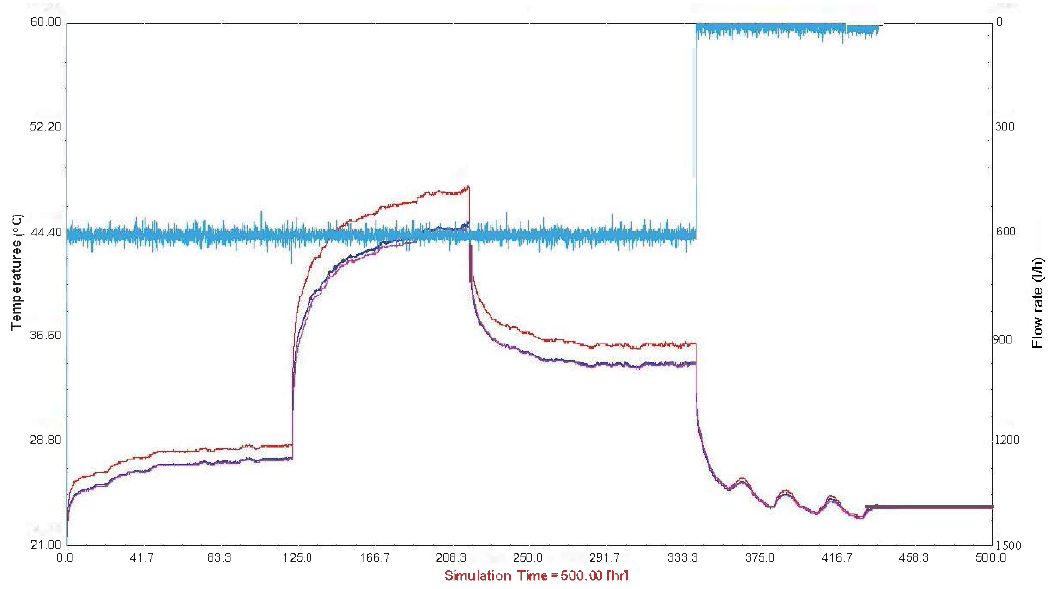
Figure 7. Output of the TRNSYS simulation. Red line is the inlet temperature. It can be compared the simulated outlet temperature (blue) versus the actual outlet temperature from the test (purple).